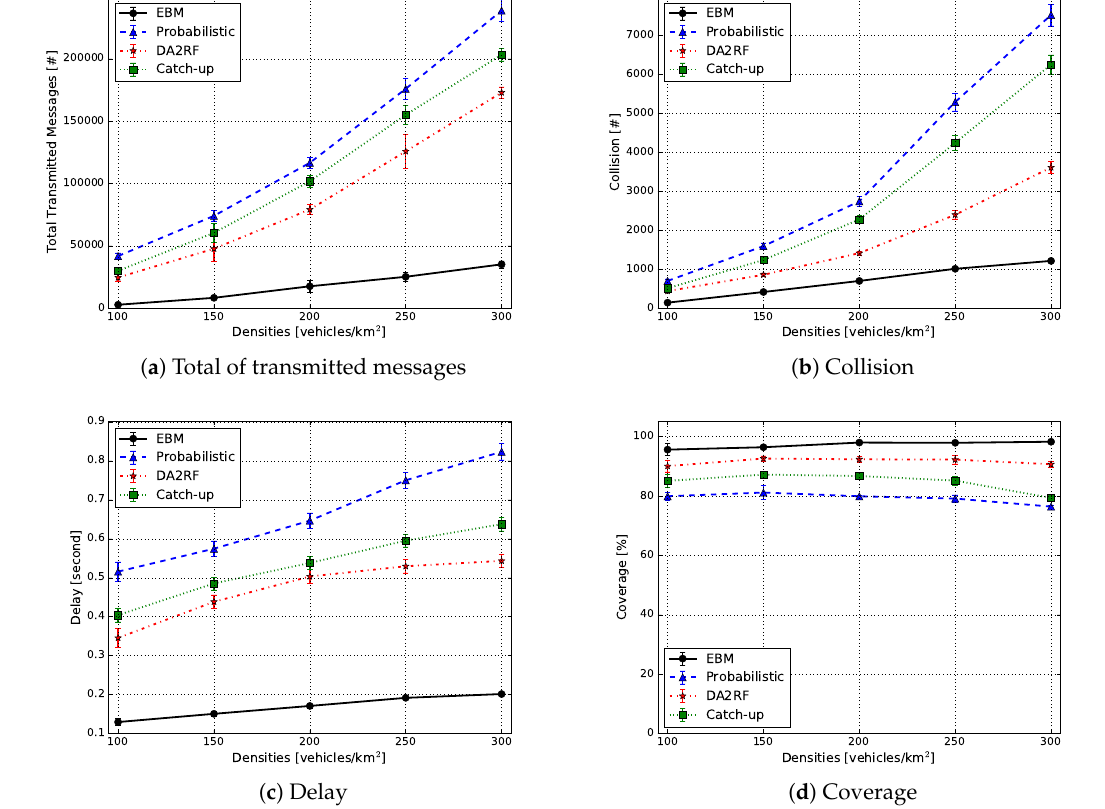
Figure 17. Knowledge generation results. EBM, egocentric betweenness